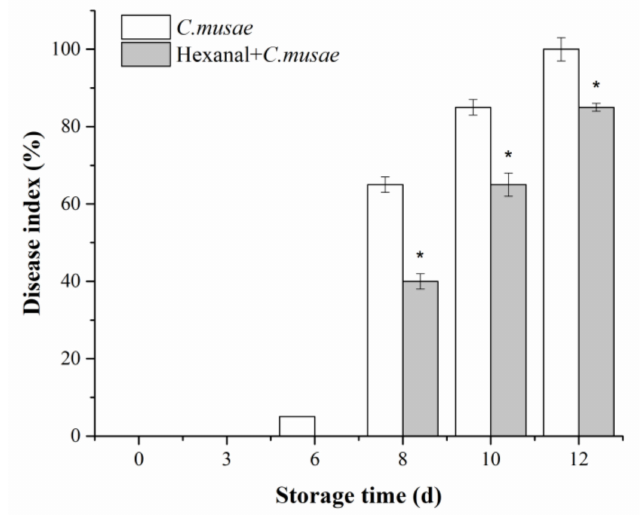
Figure 1. Effect of hexanal treatment on disease index in banana fruits infected with C. musae . The experiment was performed in triplicate. Asterisks indicated that values are significantly different between control and hexanal-treated fruits at the same time point using LSD test (* p < 0.05).